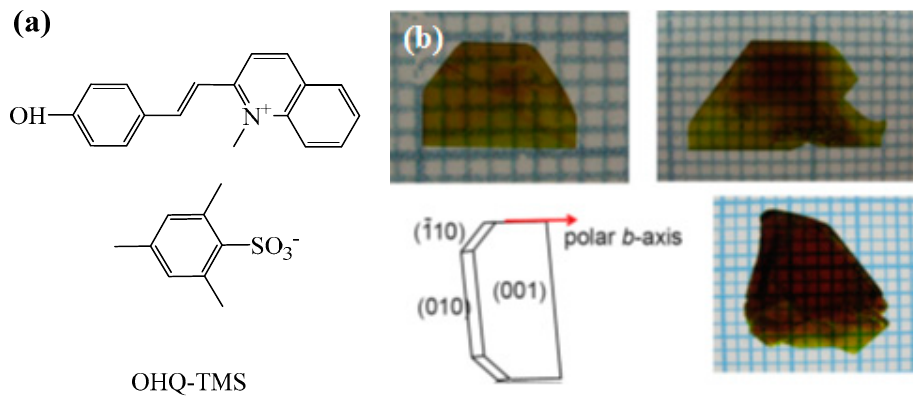
Figure 20. Molecular structure of OHQ-TMS ( a ) and single crystals of OHQ-TMS ( b ). Part E